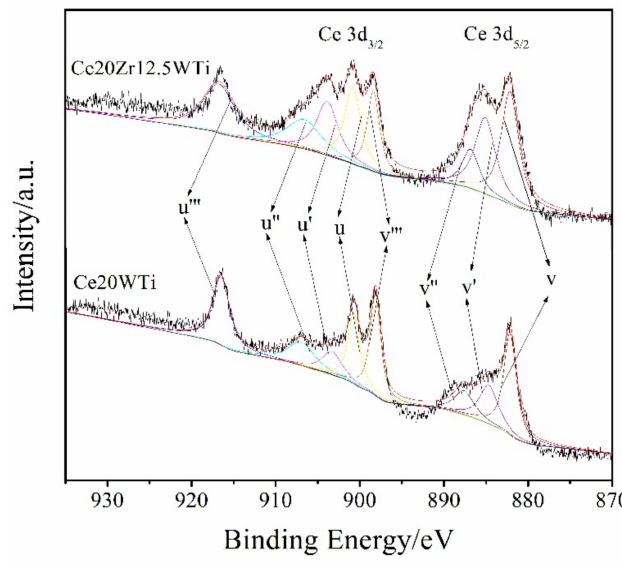
Figure 4. X-ray photoelectron spectroscopy (XPS) spectra of Ce3d for Ce x Zr y WTi